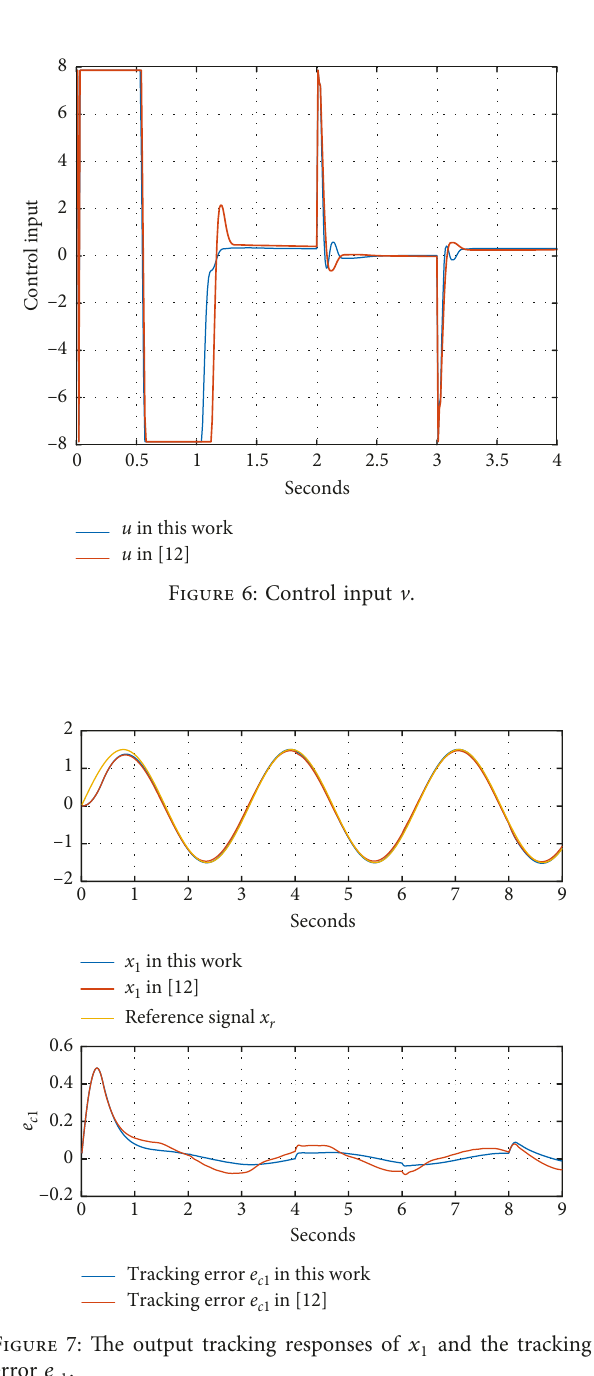
and the tracking 1